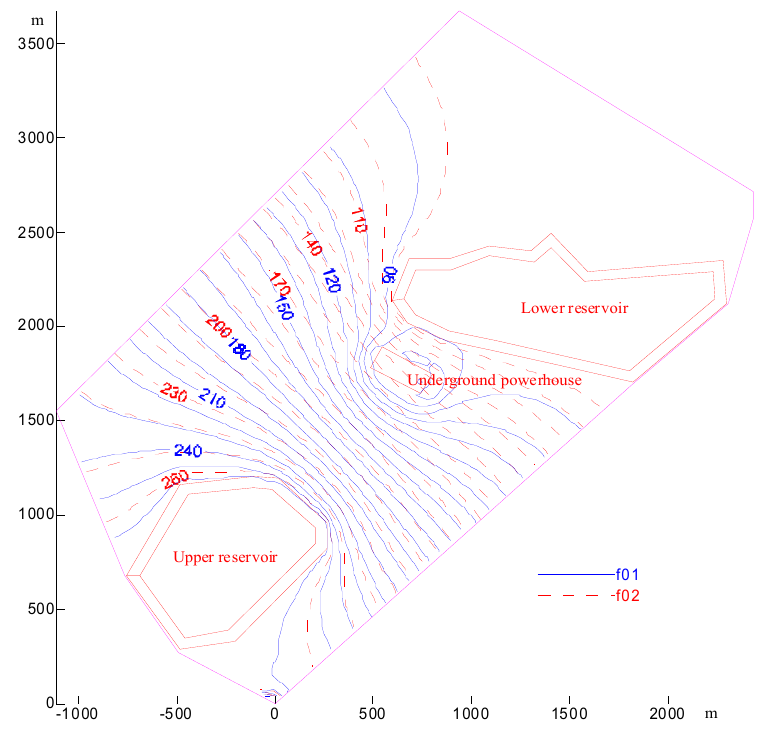
Figure 9. Contrast of groundwater level contours for schemes f01 and f02.